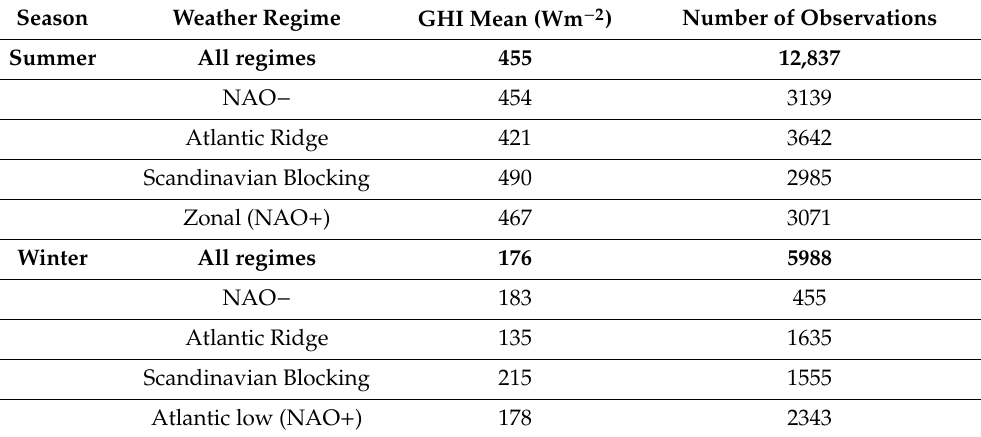
Table 1. Average ground measurements (Baseline Surface Radiation Network—BSRN Palaiseau)